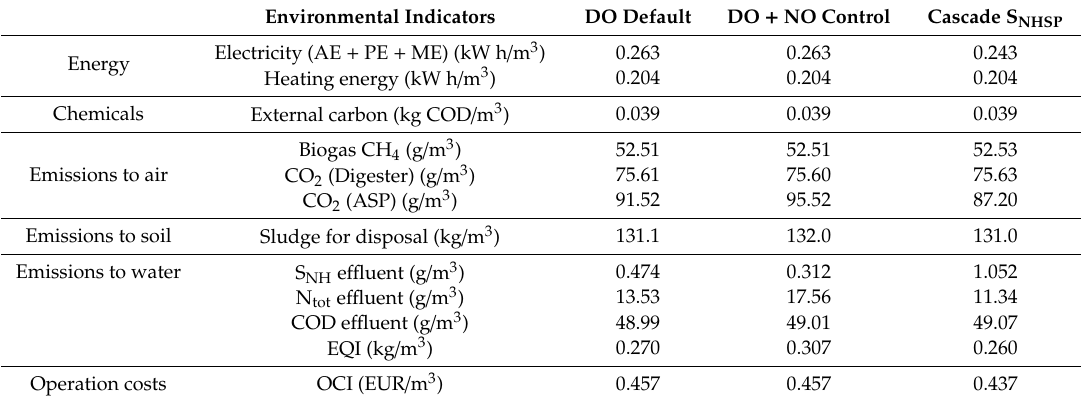
Table 3. Annual values of environmental indicators and operating costs of BSM2 plant with respect to the volume of treated wastewater with di ff erent control